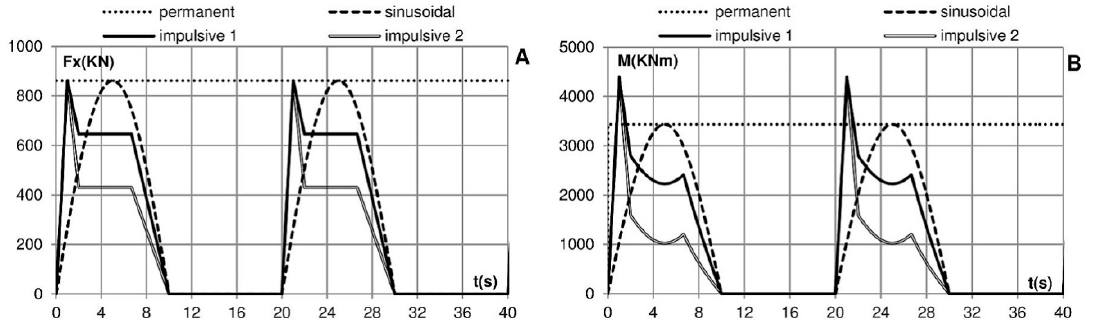
Figure 6. Shape of the load state A in the time domain: ( A ) horizontal force (F x ); ( B ) overturning moment (M).